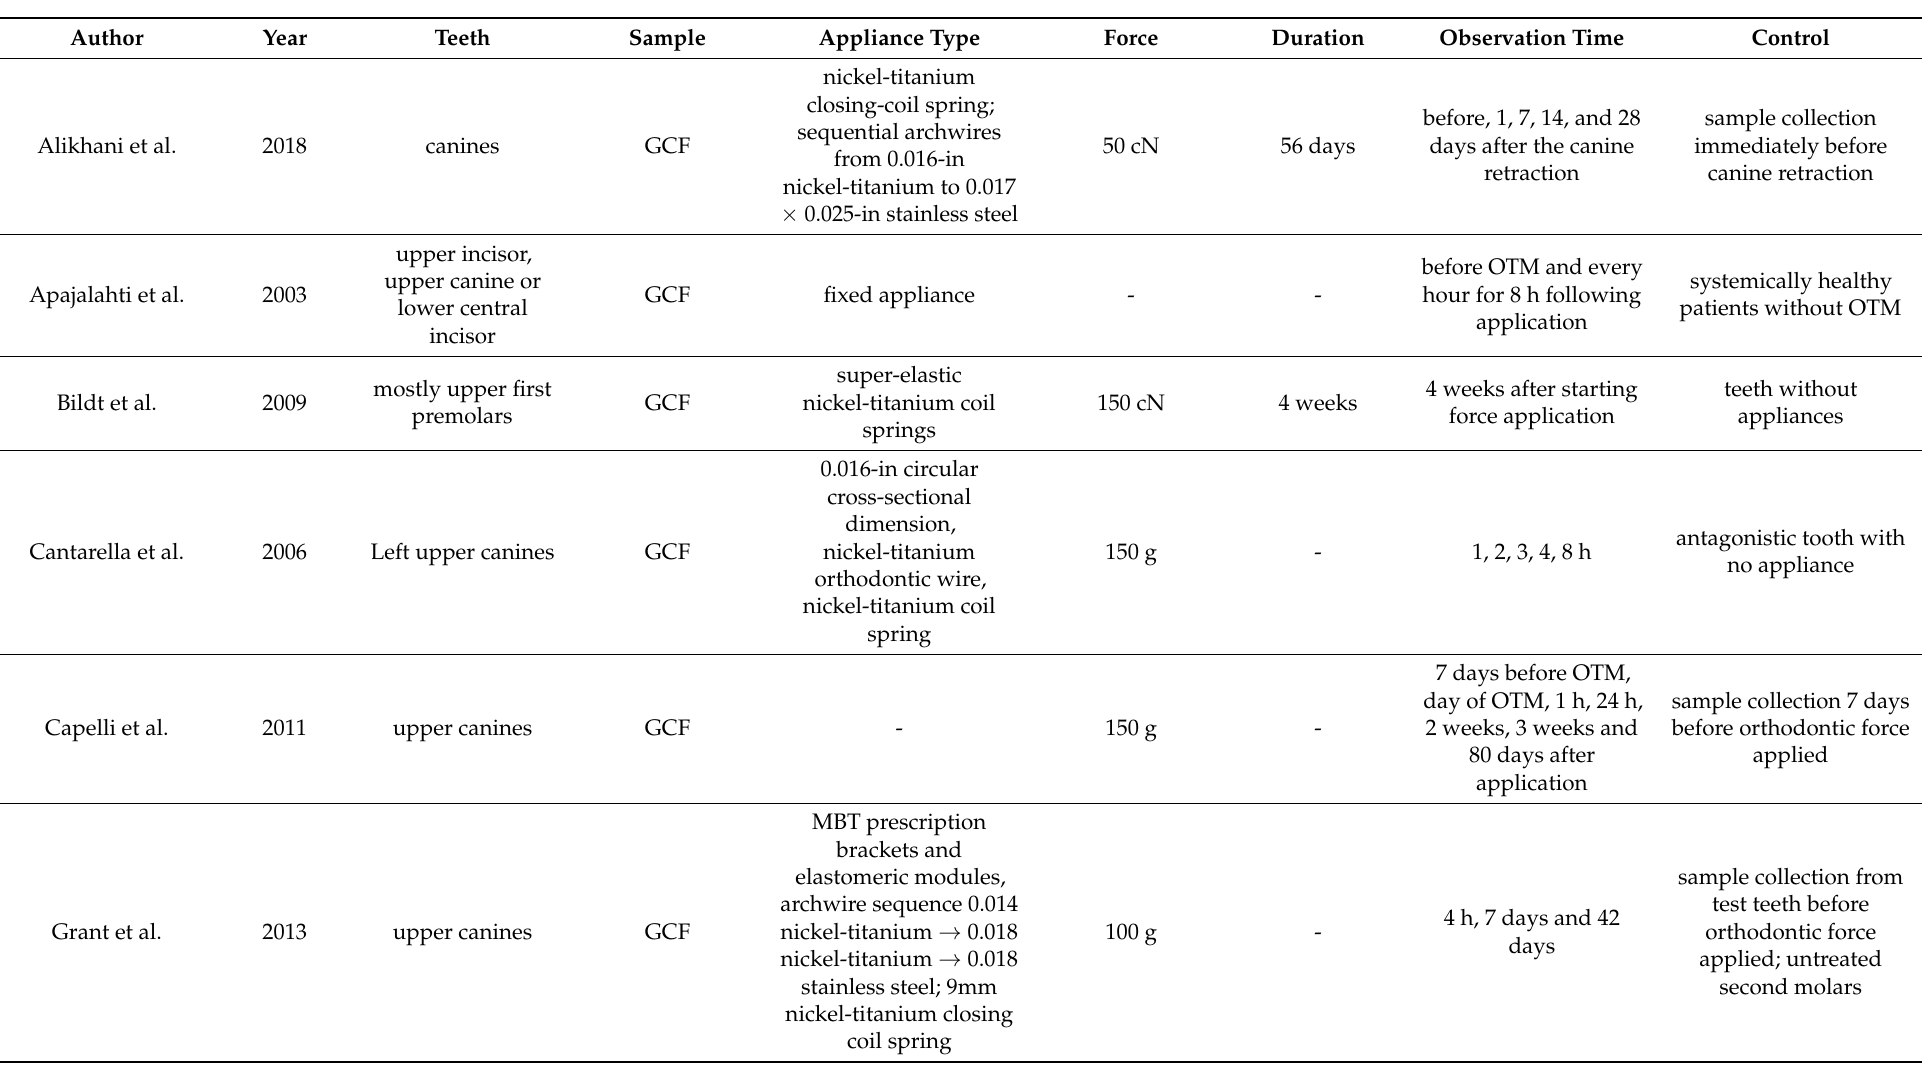
Table 6. Intervention parameters of all included in vivo